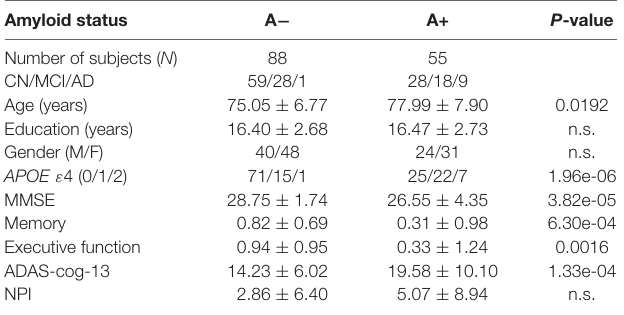
TABLE 1 | Data characteristics (A − : amyloid negative, A+ : amyloid positive, n.s.: no significant, p < 0.05). Amyloid status A − A+ P